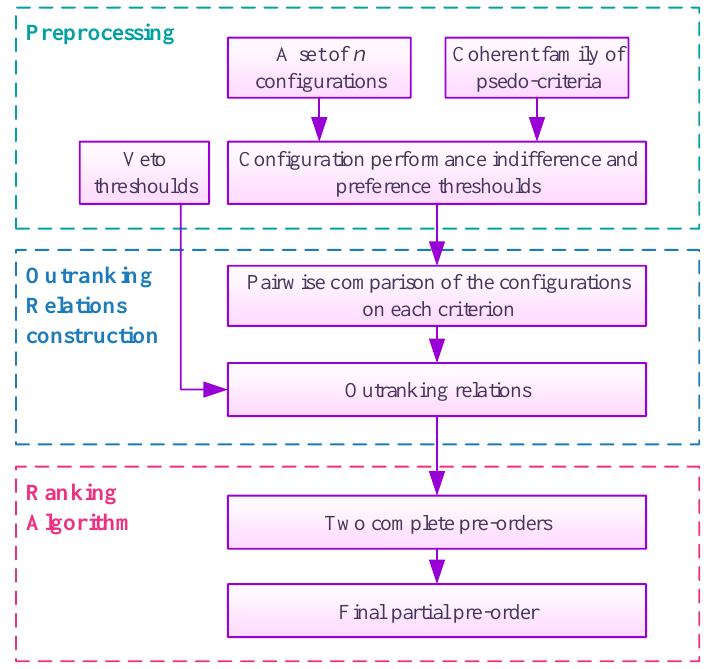
Figure 4. ELECTRE IV structure.